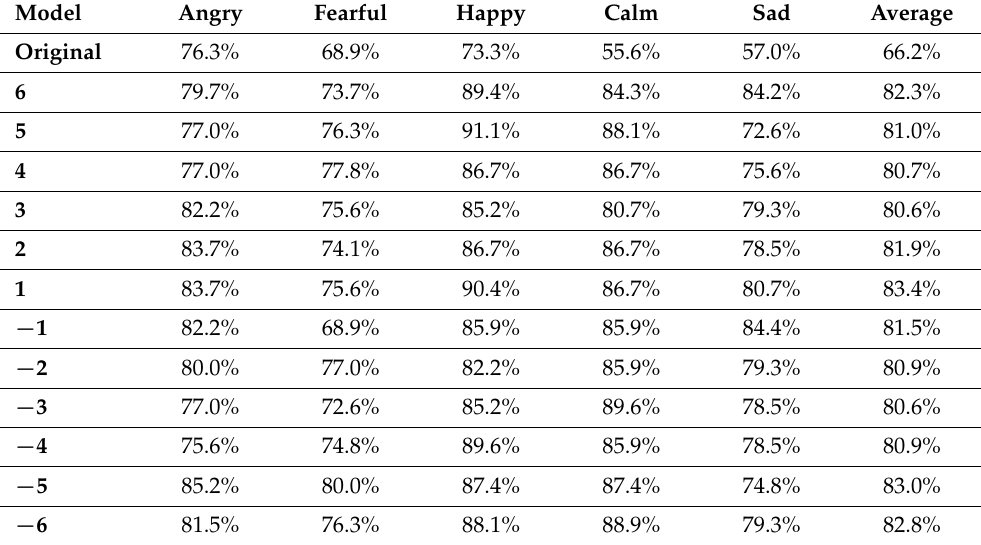
Table 4. Comparison of original method and sound pitch